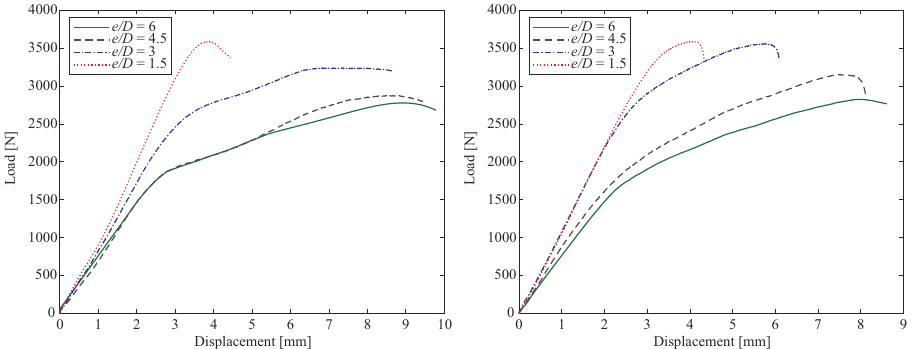
Figure 7. The ultimate bearing strength of tested specimens with various W / D and e / D ratio.